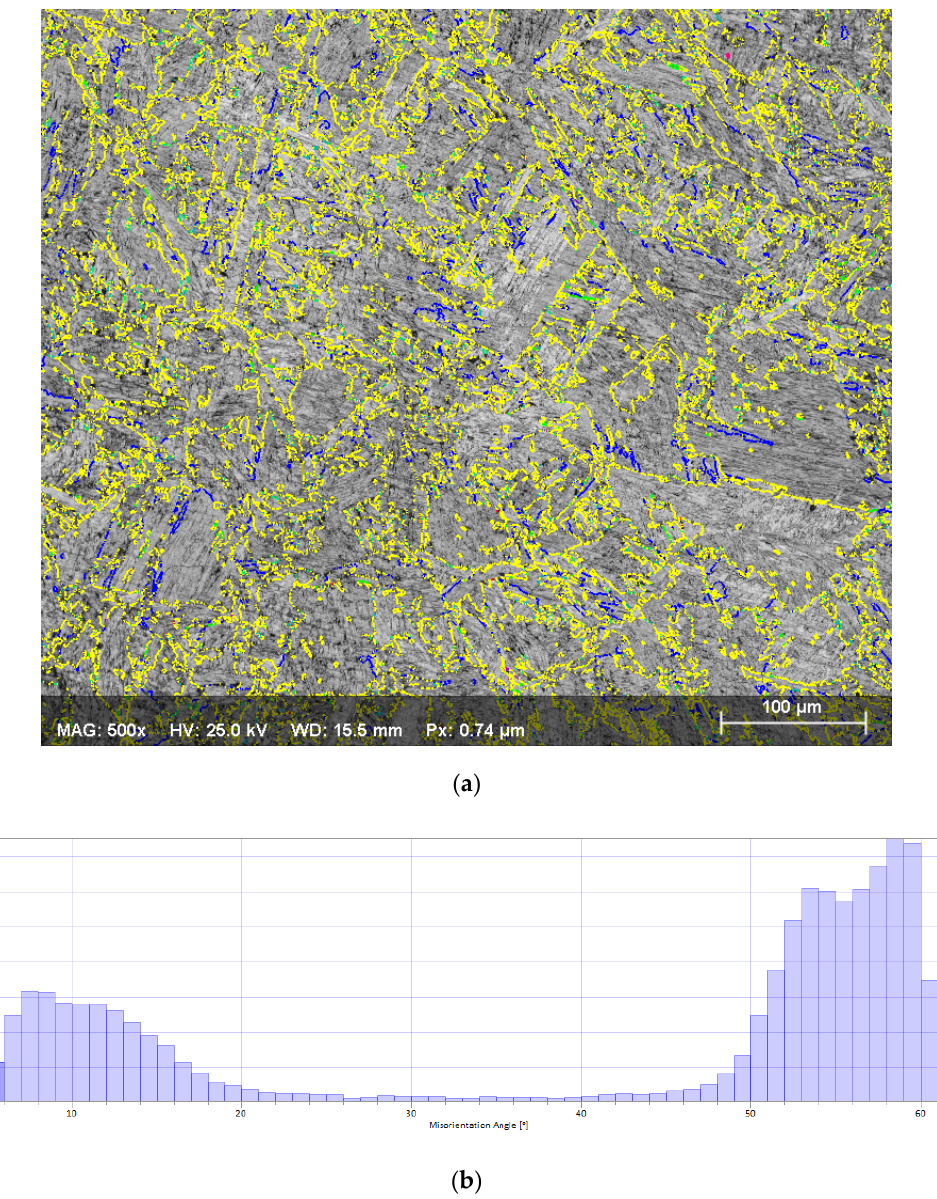
Figure 13. ( a ) Maps of boundary grain and ( b ) fraction of misorientation of boundaries grain.